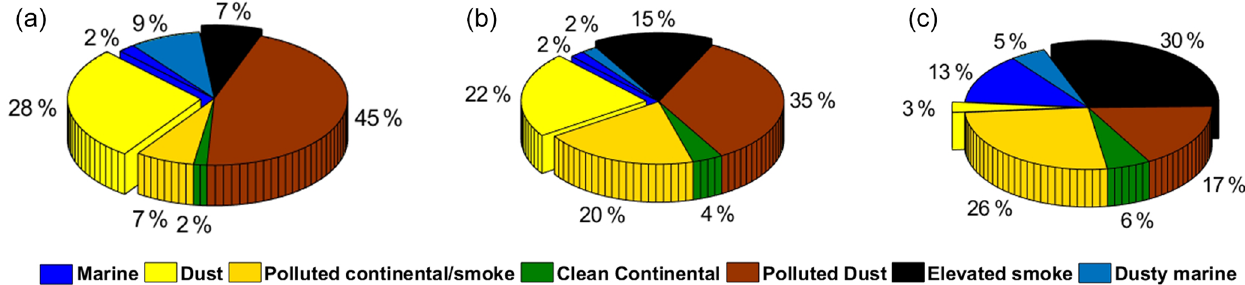
Figure 4. Relative frequencies of occurrence of different CALIOP aerosol types over the BTH (a) , YRD (b) and PRD (c) , averaged over the time period 2007–2020.